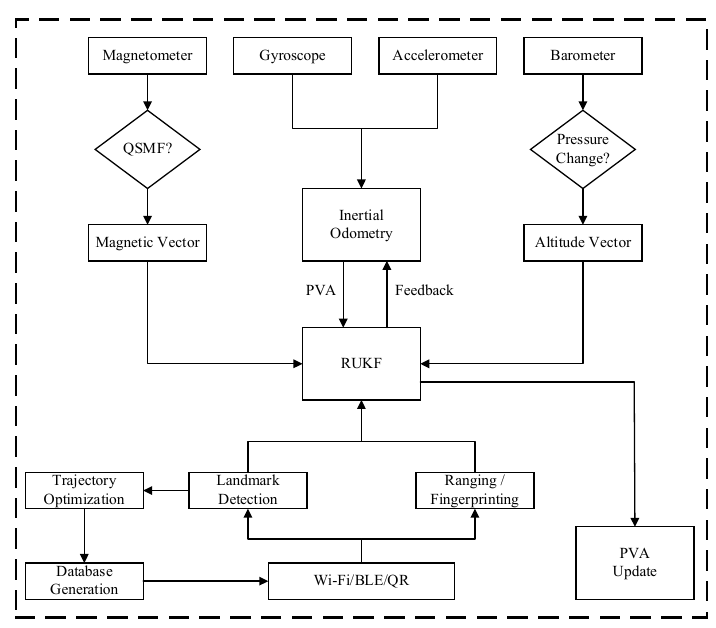
Figure 2. Framework of 3D-WBQM algorithm.